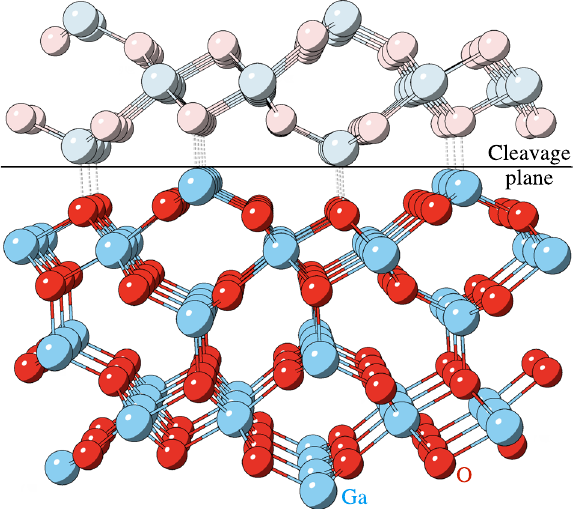
Fig. 1 Example of a cleavable crystal, Ga 2 O 3 . The (20 1 ) plane exhibits a low density of bonds that, when cleaved, creates a low energy surface.